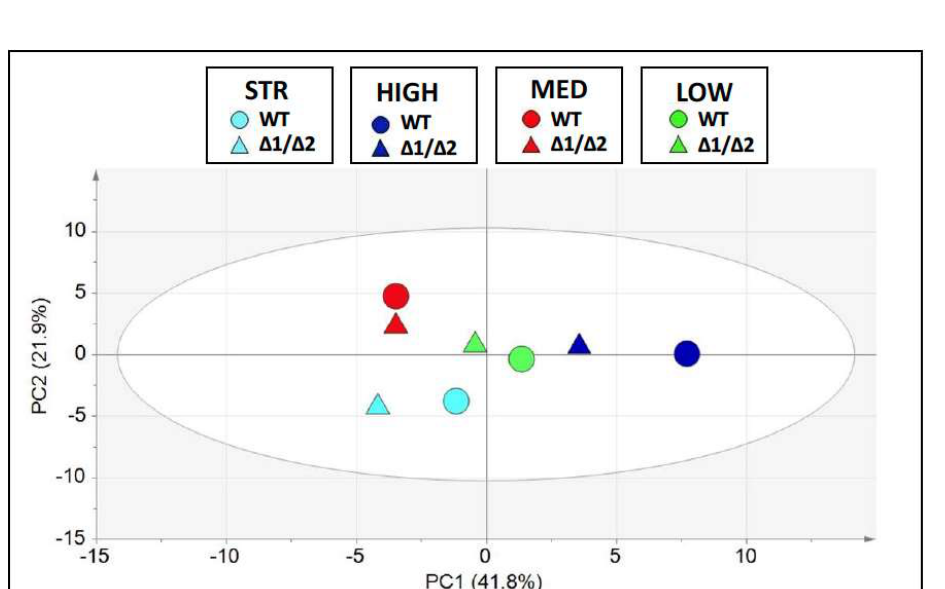
Figure 7. Principal component analysis (PCA). Score plot of the volatile compounds obtained by GC-MS data (see Supplementary Table S1) of WT (circles) and ∆ SUL1 / ∆ SUL2 ( ∆ 1 / ∆ 2 , triangles) yeast strains. The four strains (STR, HIGH, MED, and LOW) are discriminated by using different colours. The percentage of variance explained by the first two principal components (PC1 and PC2) is reported on each axis of the plot. Ellipse: Hotelling’s T2 (95%).